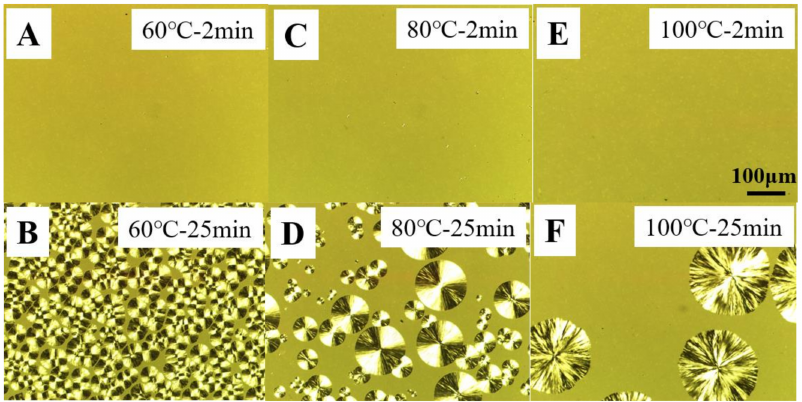
Figure 5. POM images of the PLLA/TAIC (60/40) blend upon isothermal melt crystallization at 60 ◦ C ( A , B ), 80 ◦ C ( C , D ), and 100 ◦ C ( E , F ) for the indicated time